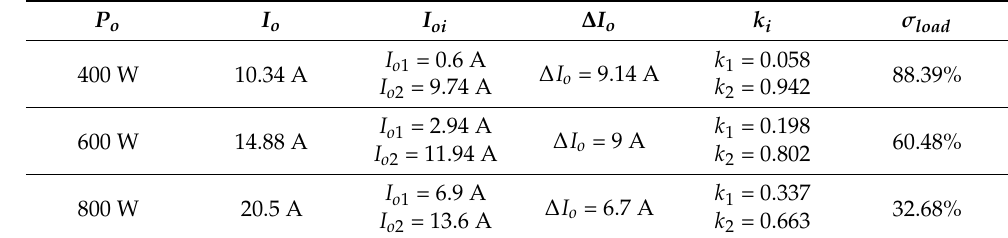
( a ) R o = 4 Ω , P o = 400 W; ( b ) R o = 2.667 Ω , P o = 600 W; ( c ) R o = 2 Ω , P o = 800 W.